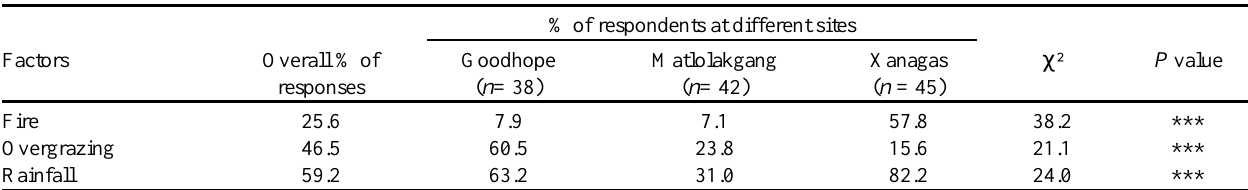
% of respondents at different sites